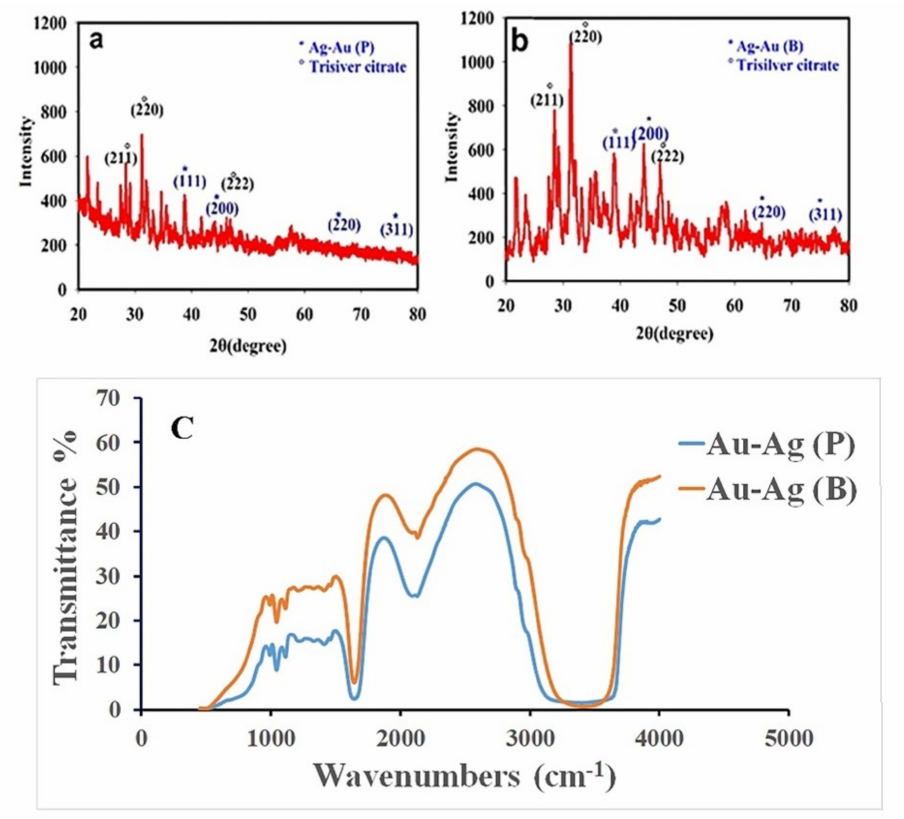
Figure 2. XRD patterns of ( a ) Au@Ag (P); ( b ) Au@Ag (B); and ( c ) FT-IR spectra of Au@Ag (P) and Au@Ag